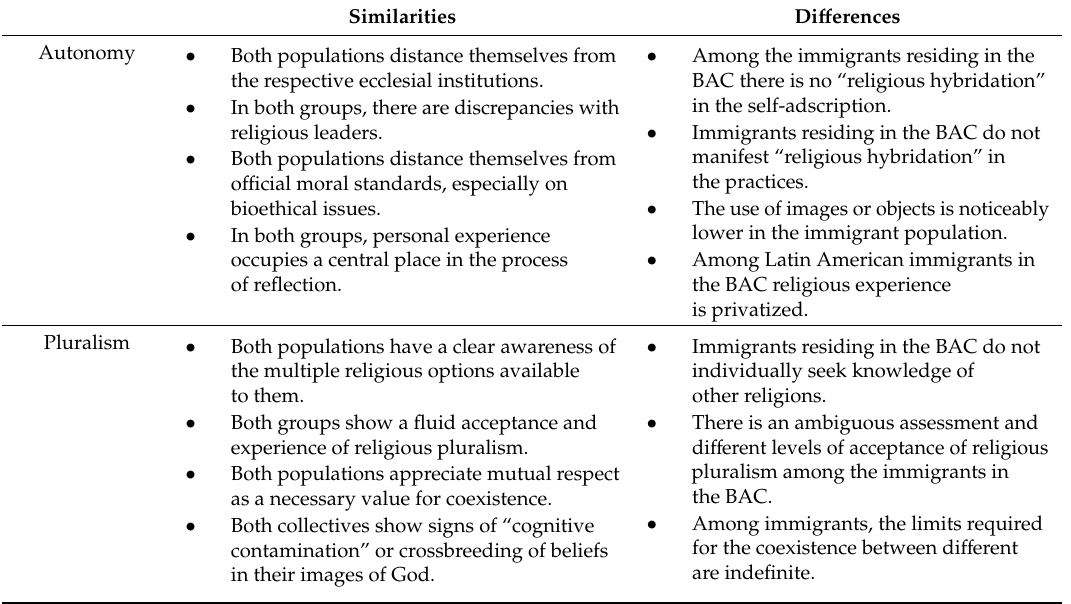
Table 6. Summary. Comparison between the Latin American population of Argentina, Peru, Uruguay, and the immigrant population of the